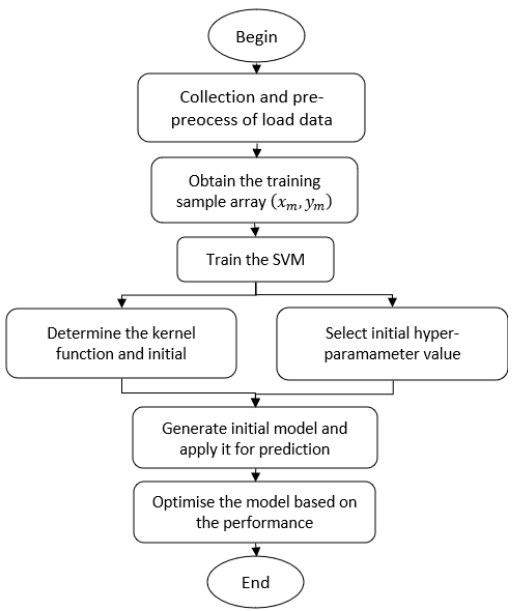
Figure 7. SVM prediction flow chart.